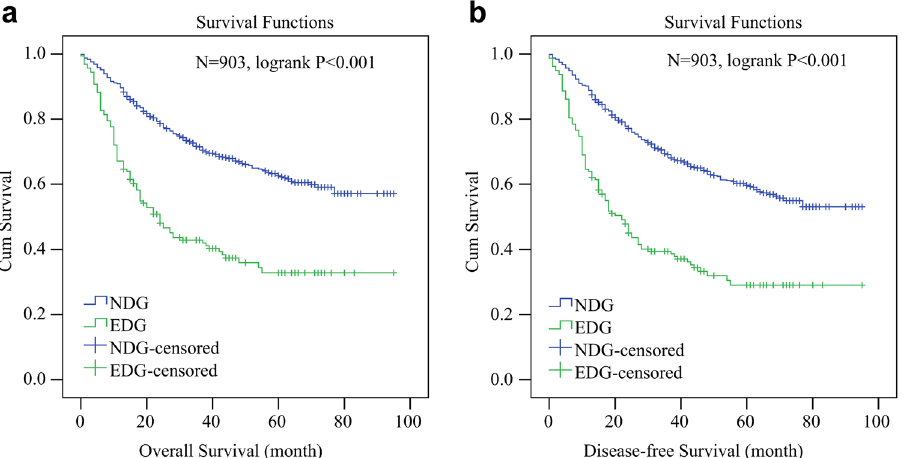
Figure 2. Kaplan–Meier (KM) survival curves for whole GC patient series who underwent radical gastrectomy (N = 903). ( a ) the 5-year overall survival rate was 62.6% for NDG and 32.8% for EDG (P < 0.001). ( b ) the 5-year disease-free survival rate was 59.6% for NDG and 29% for EDG (P < 0.001).